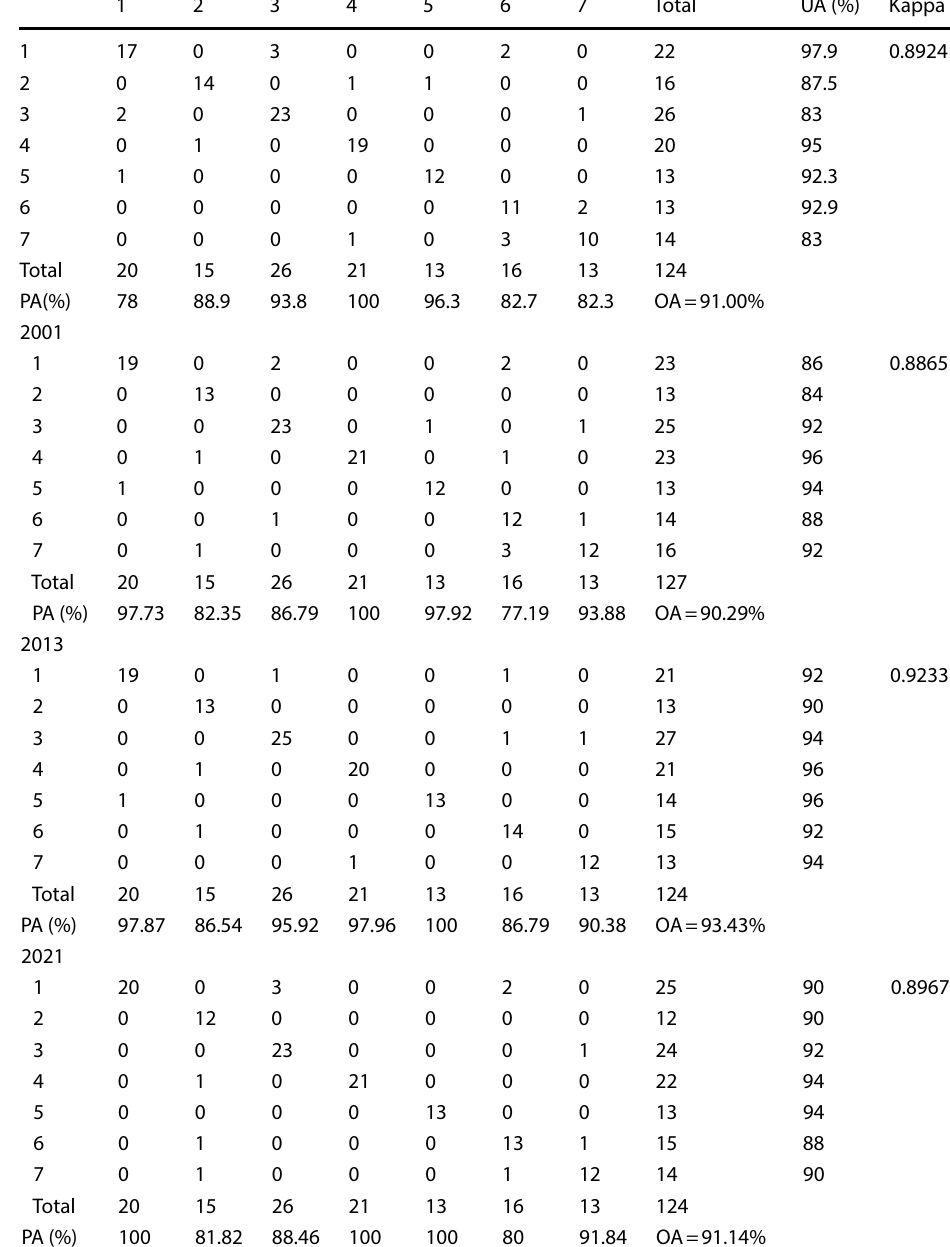
Table 2 Accuracy assessment of the LULC maps produced from Landsat data representing both confusion matrix and the Kappa